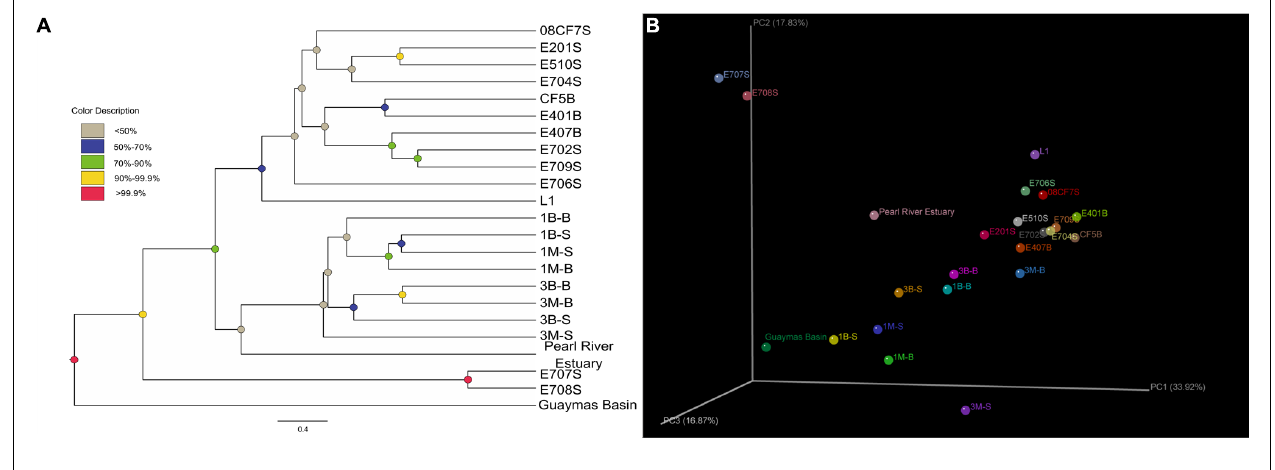
FIGURE 5 | (A) Weighted Jackknife sample cluster analysis was conducted by setting the minimum sample counts as 42, permutation numbers as 1000. Finally, the clustering results were shown in (A) . Different node colors showed different confidence values of each cluster; (B) Weighted 3D PCoA